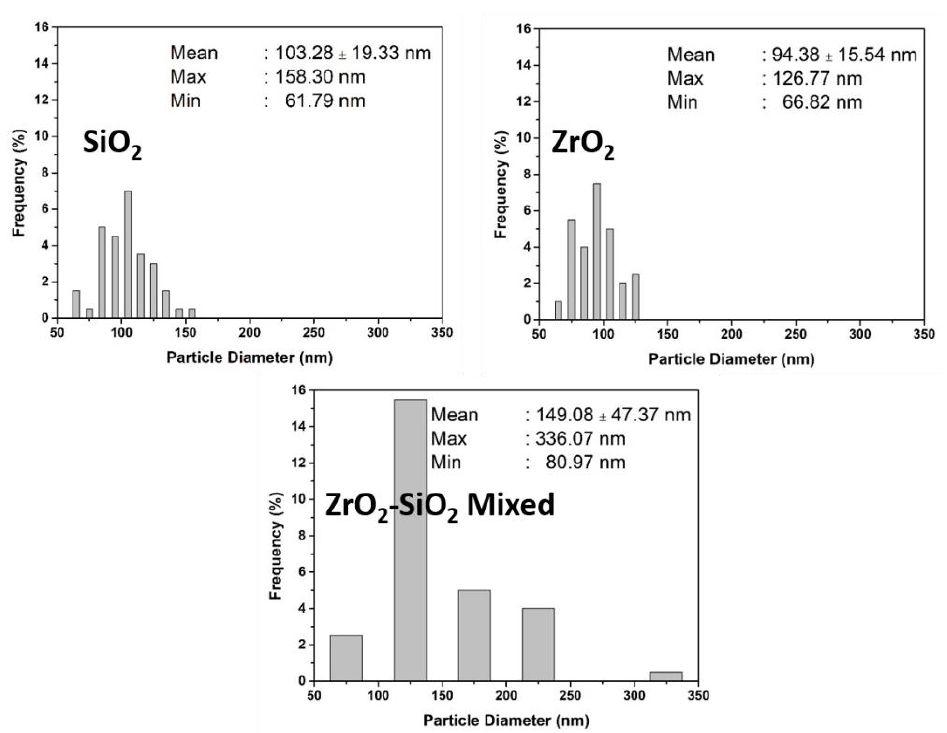
Figure 4. The SEM images of SiO 2 , ZrO 2, and ZrO 2 -SiO 2 mixed fillers.